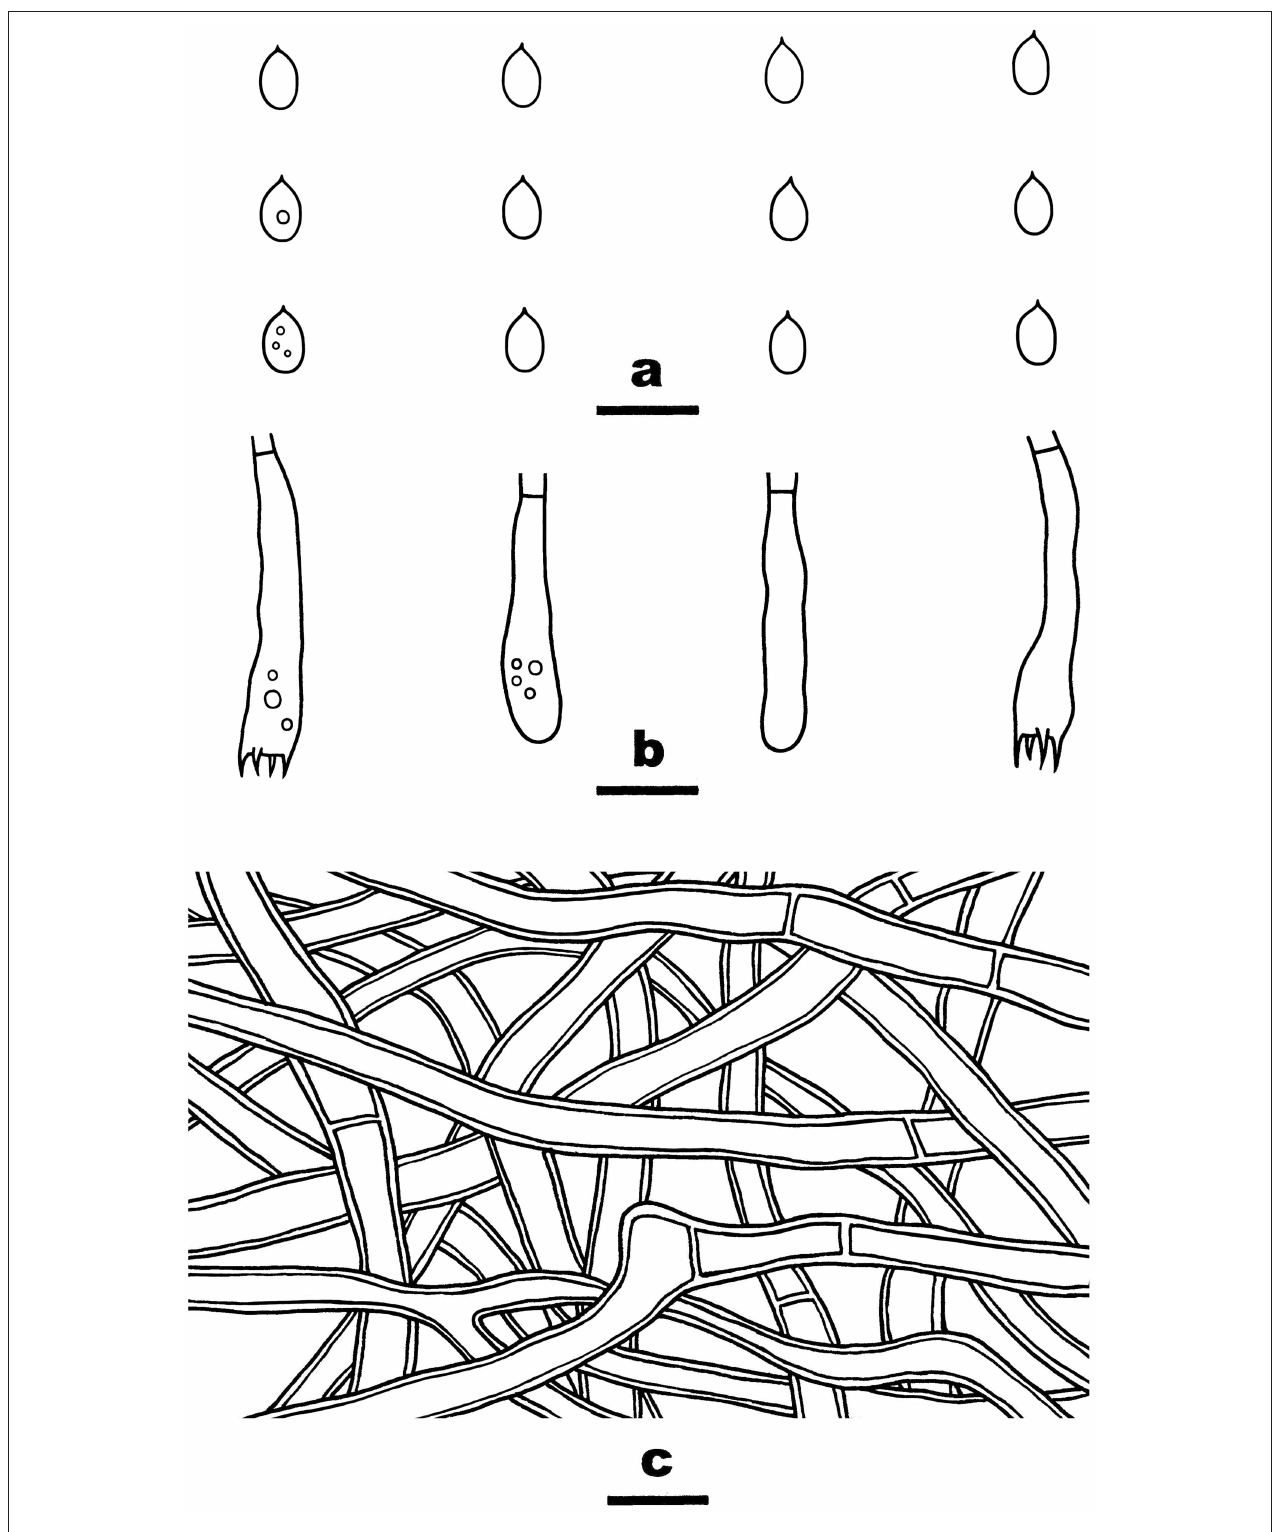
FIGURE 10 | Irpex rosea (from He 6277; scale bars: a–c = 10 µ m). (A) Basidiospores. (B) Basidia and basidioles. (C) Hyphae from subiculum.